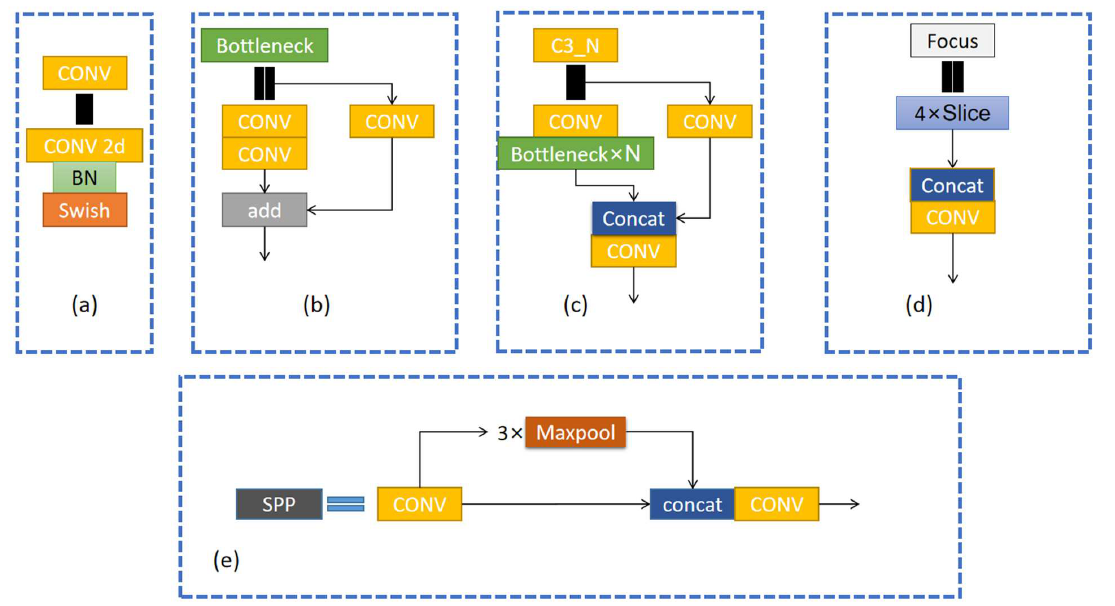
Figure 2. The detailed composition of each module in the BE-YOLOv5S network structure. ( a ) CONV module, ( b ) Bottleneck module ( c ) C3 × N module ( d ) Focus module, and ( e ) SPP module.